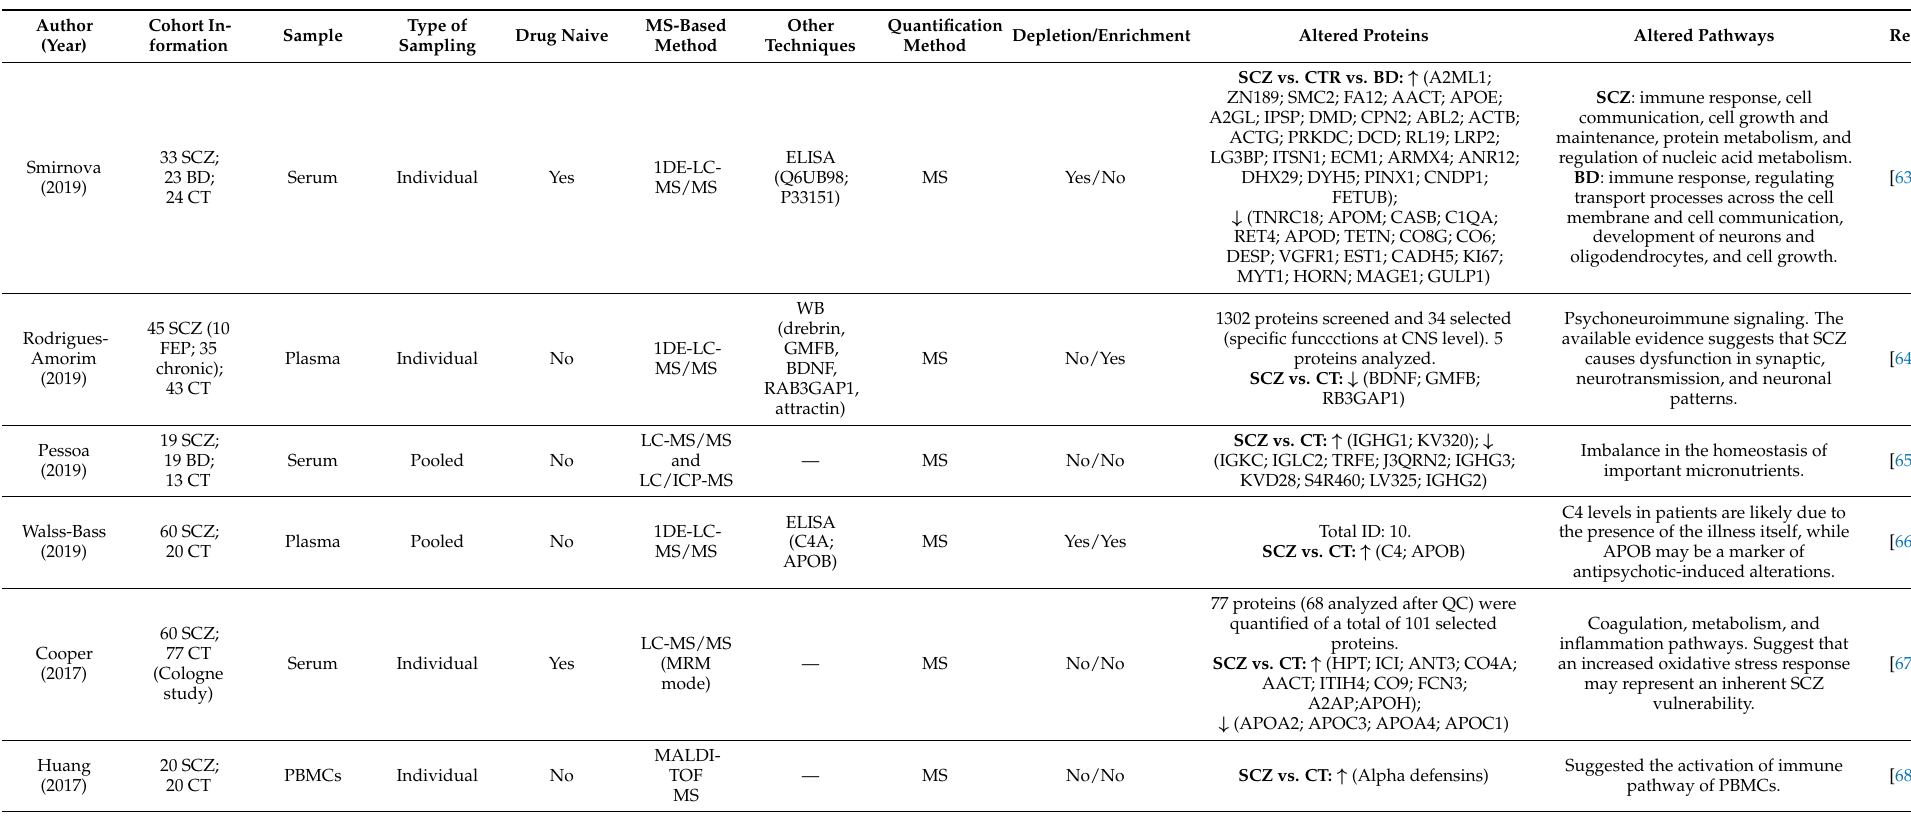
Table 2. Proteomic studies of schizophrenia and biomarkers discovery using MS-based method in human peripheral fluids. The proteins identified as altered are represented by their entry name as described in UniProt (the corresponding protein name and accession number are described in Supplementary Information, Table